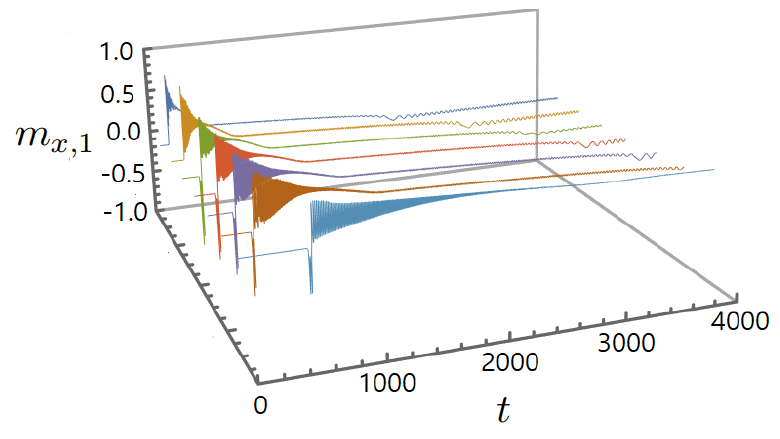
Figure 10: Same as in Fig.9 without the time shift, and for τ = 250 (blue curve), τ = 500 (orange curve), τ = 750 (green curve), τ = 1000 (red curve), τ = 1250 (purple curve), τ = 1500 (brown curve), τ = 5000 (light blue curve).